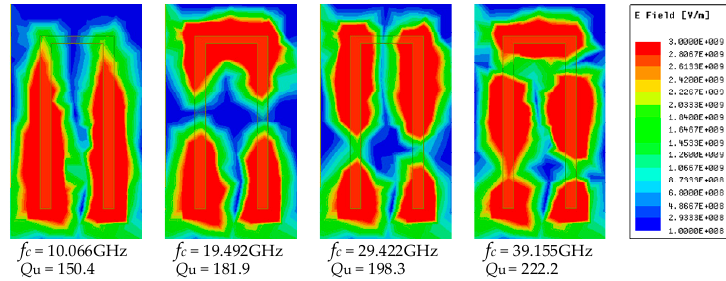
Figure 3. Electric field distributions of the lowest four modes in the USIR.